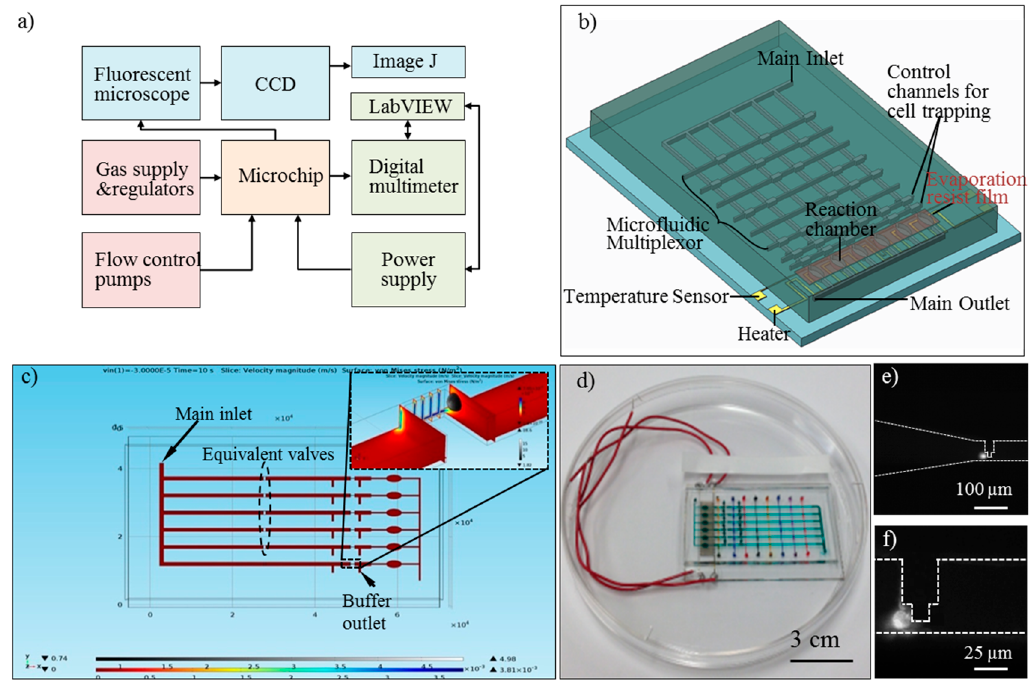
Figure 2. ( a ) Schematic of the experimental setup (arrow symbol means ‘input’); ( b ) Schematic of the multilayer microchip; ( c ) 3-D transient simulation results of on-chip single cell trapping in COMSOL software; ( d ) A fabricated microchip prototype; ( e ) An on-chip immobilized single cell; and ( f ) Details of the trapping zone and the single cell.